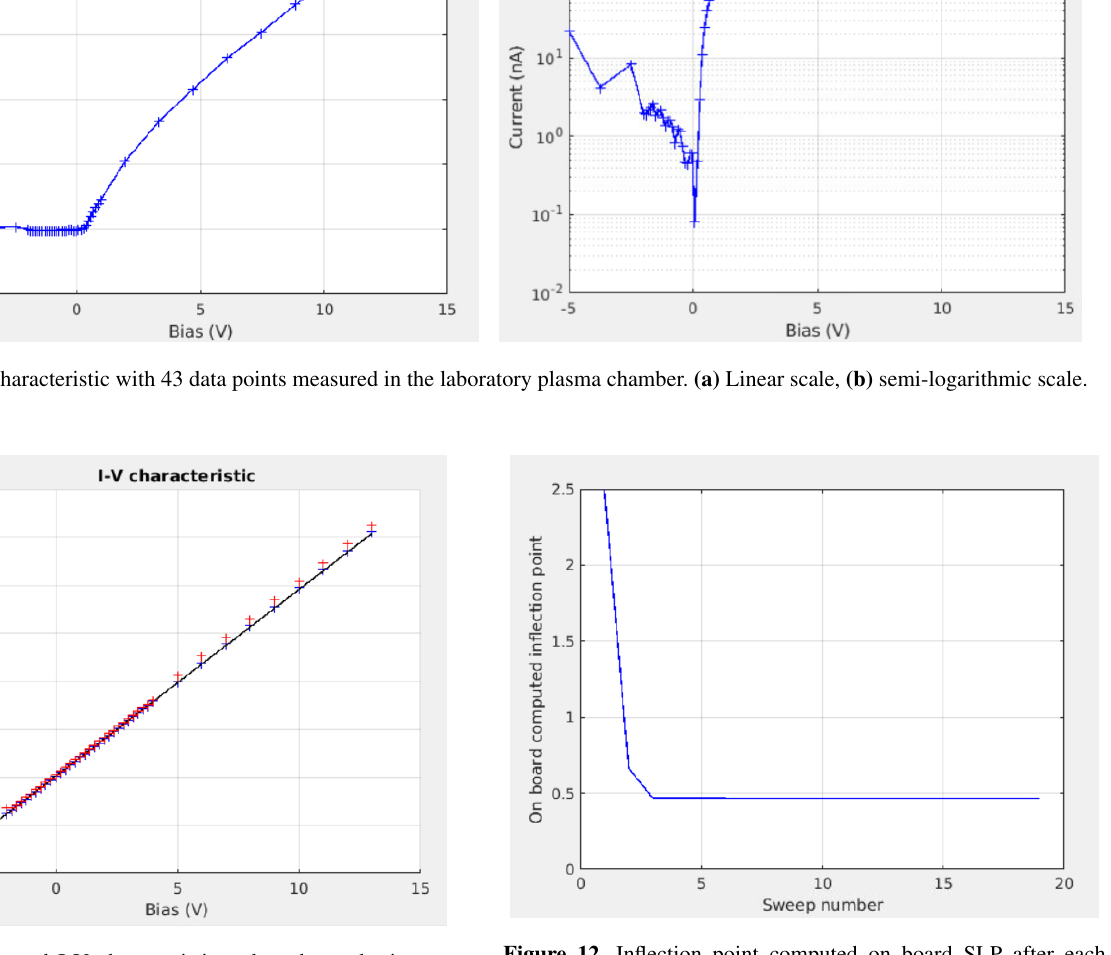
Figure 11. Measured I-V characteristics when the probe is con- nected directly to a 50Mohm resistor. Delay between samples set to 300µs (red) and 600µs (blue). For reference, the expected ideal curve is plotted in black.